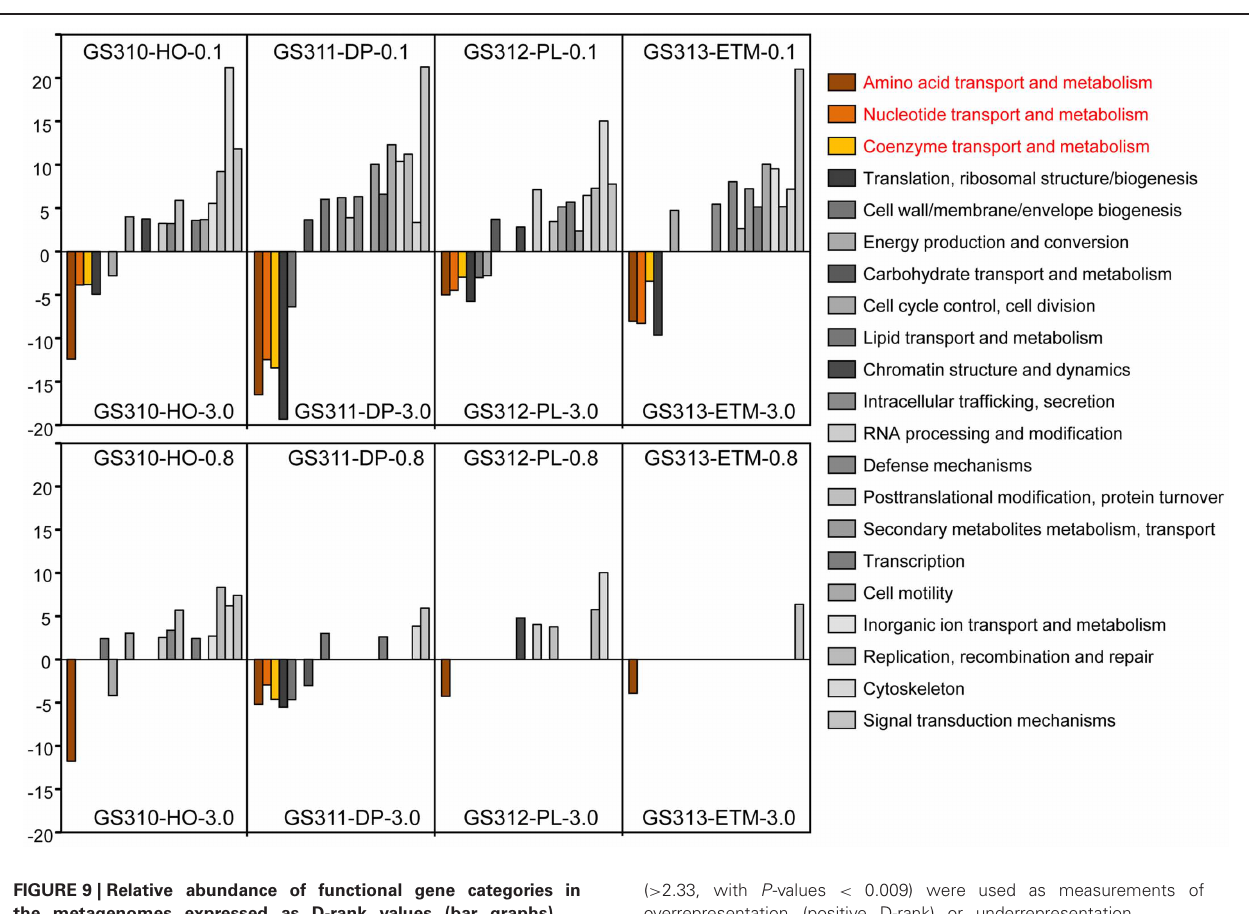
( > 2.33, with P -values < 0.009) were used as measurements of overrepresentation (positive D-rank) or underrepresentation (negative D-rank). Functional gene categories related to transport of amino acids, nucleotides and coenzymes are colored brown and